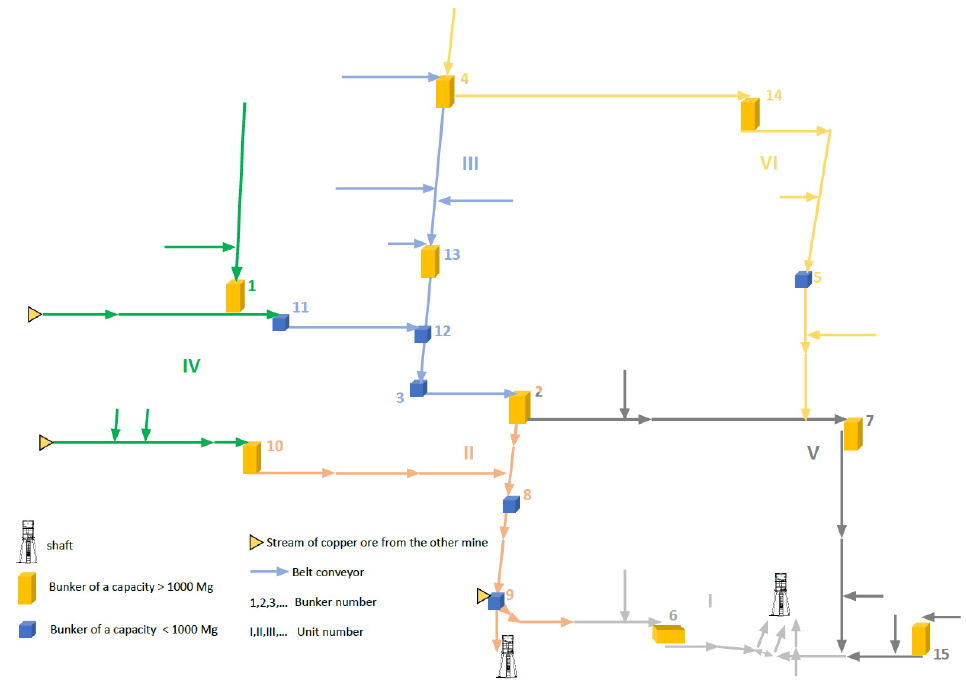
Figure 4. Locations of the bunkers within the transportation system of the mine.